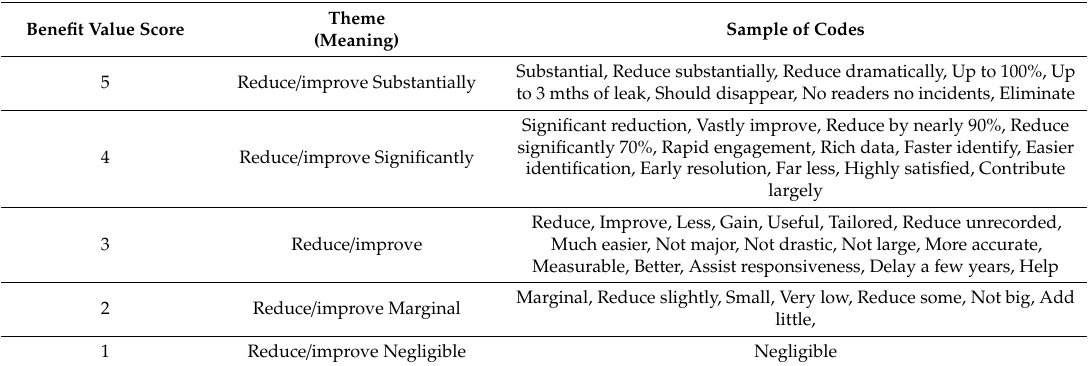
Table 5. Coding keywords of benefit value scoring from expert assessments.